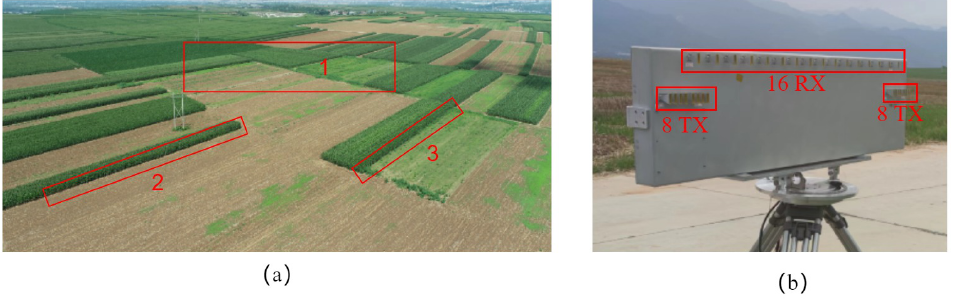
Figure 8. Experiment scene and system. ( a ) Low-lying and wide open fields. ( b ) GB-SAR system with 16 TX and 16 RX.